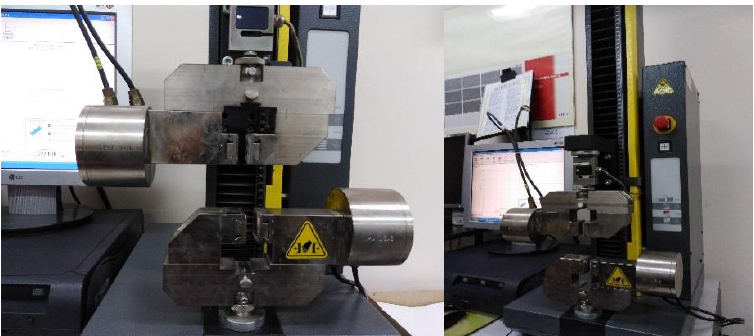
Figure 2. The apparatus used for measurement of the mechanical properties (Zwick ZW2.5/TNIP).